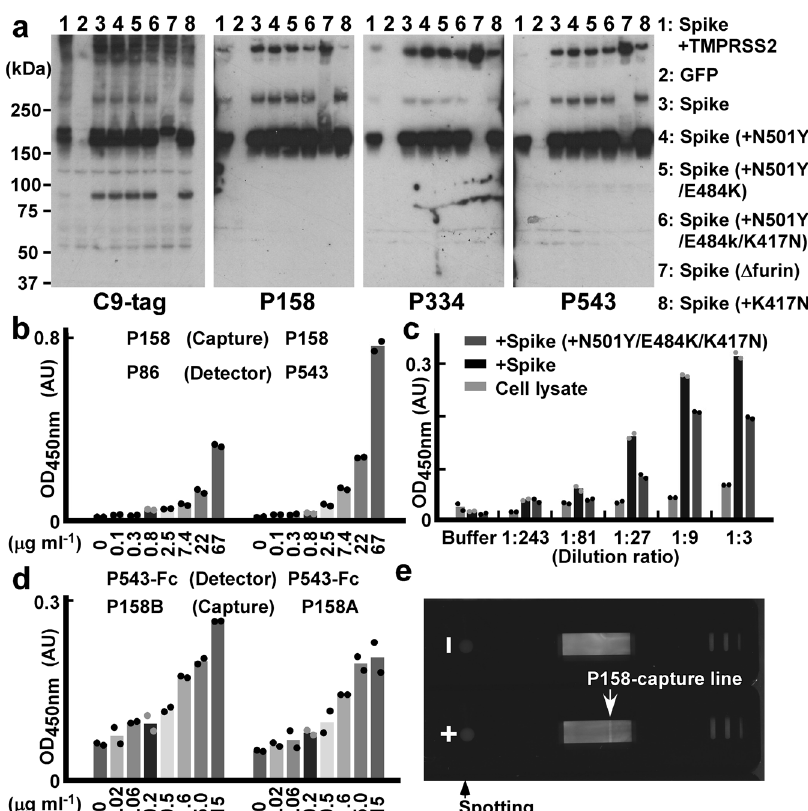
Fig. 2 Nanobodies for western blotting assays, ELISAs and lateral fl ow assays. a Nanobody-based western blotting assays of SARS-CoV-2 spikes: lysates of HEK293T cells expressing GFP or C-terminally C9-tagged SARS-CoV-2 spike (D614G) variants (indicated with numbers) were blotted with the indicated nanobodies. b – d Sandwich ELISA: b signals of gradually diluted sample concentrations using P158 as the capture antibody and P86 or P543 ( b , c ) or P543- Fc ( d ) as the detection antibodies are graphed as a mean of the measurements from two technical replicates. In c , sequentially diluted lysates of HEK293T cells expressing the original SARS-CoV-2 spike (D614G) or Beta variant (D614G, N501Y, E484K and K417N) were assayed. Data are representative of one independent experiment out of two biologically independent experiments. e A photograph of the results from lateral fl ow nitrocellulose membrane assays: P158 for the capture line (allow head) and P86 for the detection beads; 300 ng of the puri fi ed SARS-CoV-2 spike Delta variant (D614G, L452R and T478K) ( + ) or PBS ( – ) was